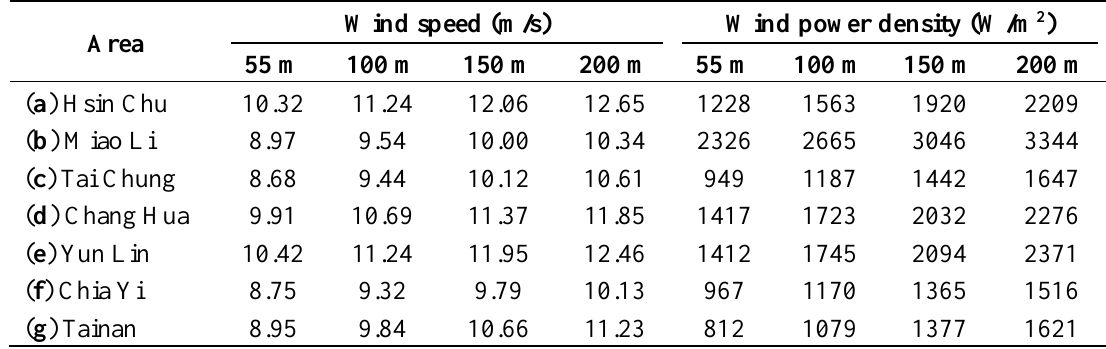
Table 3. Average wind speed and wind power density.